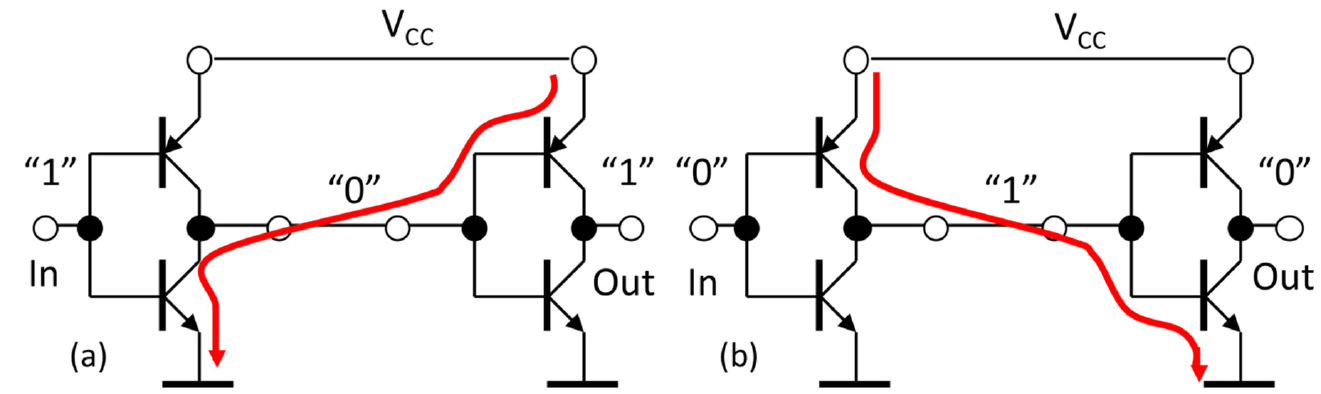
Figure 2. Currents in a pair of CBip inverters: ( a ) with “1” at input; ( b ) with “0” at input.